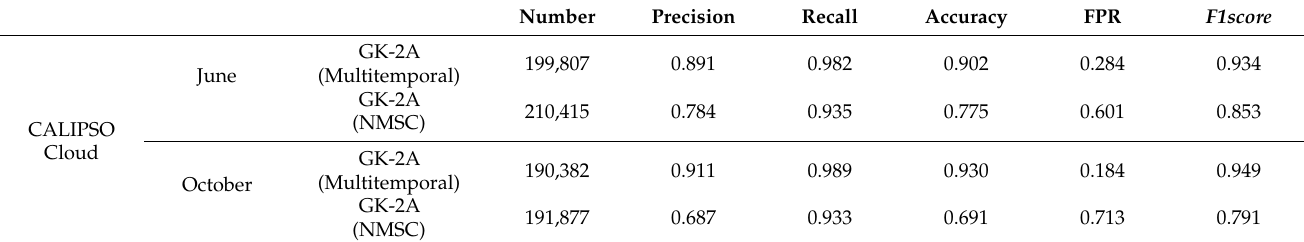
Table 3. Quantitative validation results with CALIPSO cloud products.